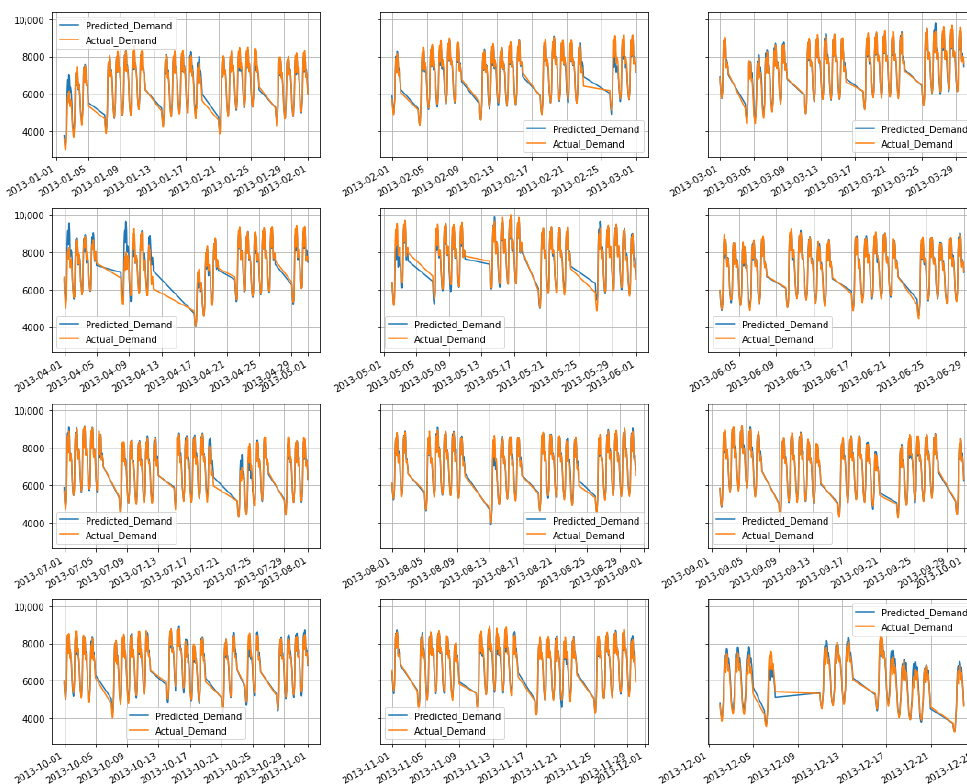
Figure A1. Forecasting performance of the VR model (Group 1).